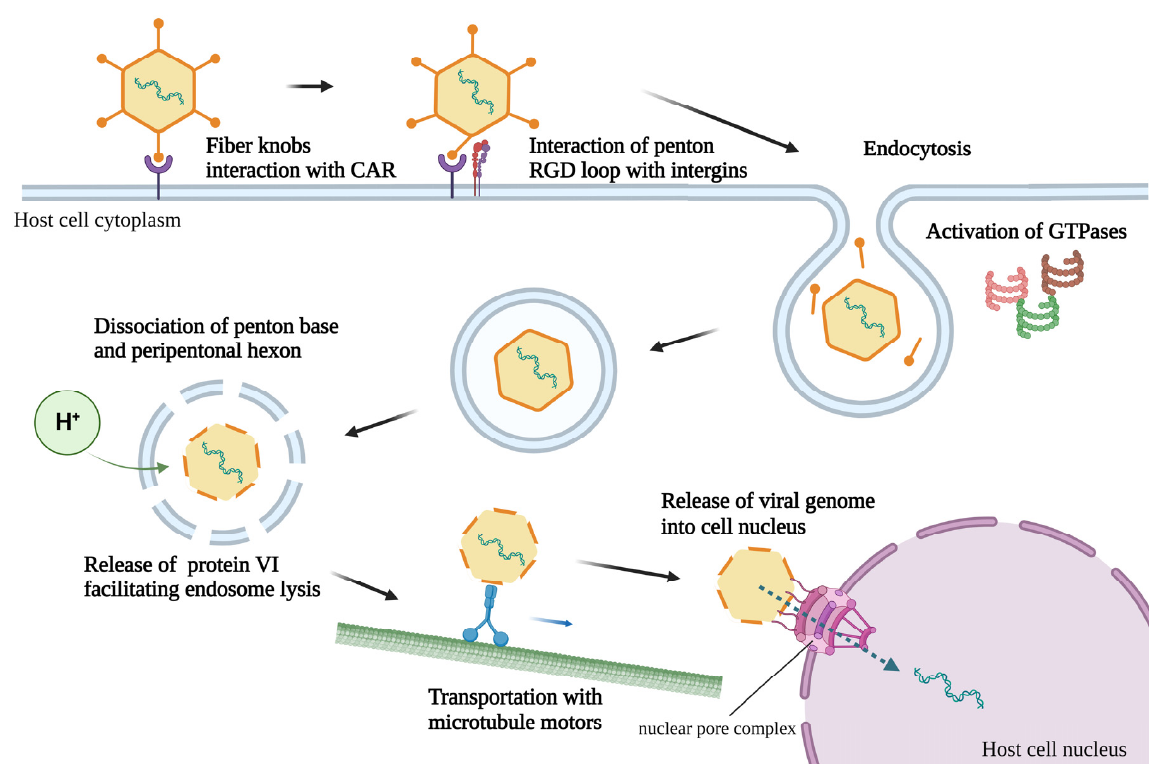
Figure 2. Transportation of human adenovirus type 5 or its genome within a host cell. The adenoviral knob domain binds to the CAR on the host cell surface. Following receptor binding, the fibers start to disassociate, exposing the RGD loop of the penton to interact with α v integrins, thereby initiating endocytosis. The endosome’s acidic environment results in the dissociation of the penton base